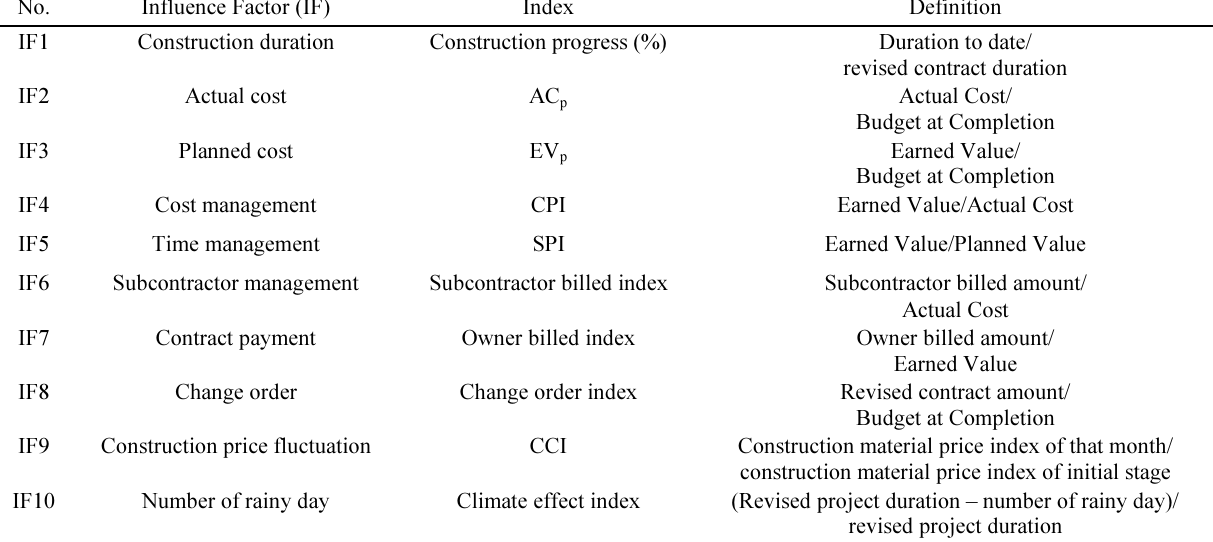
Table 1. EAC prediction’s influencing